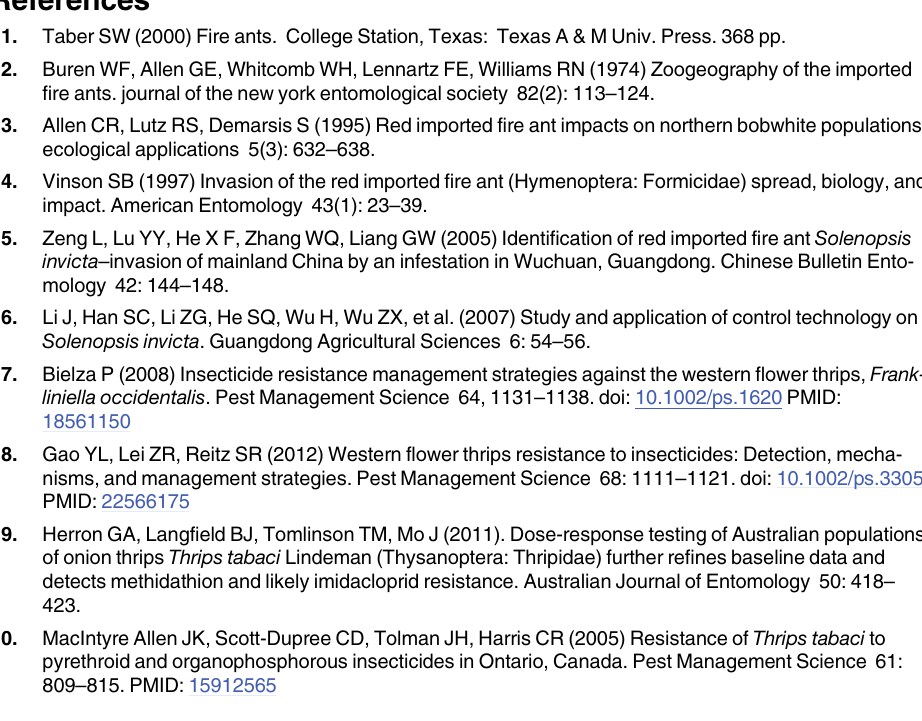
S7 Fig. Decrease rate of nest after treatment of S . invicta with various doses of strain ZGNKY-5. (A) The decrease rate of nest at day 4; (B) The decrease rate of nest at day 10; (C) The decrease rate of nest at day 20; (D) The decrease rate of nest at day 30. S8 Fig. Decrease rate of worker ants after treatment of S . invicta with various doses of strain ZGNKY-5. (A) The decreasing rate of worker ants at day 4; (B) The decreasing rate of worker ants at day 10; (C) The decreasing rate of worker ants at day 20; (D) The decreasing rate of worker ants at day 30. S1 Table. Origin of the B . bassiana fungal isolates screened against S . invicta .